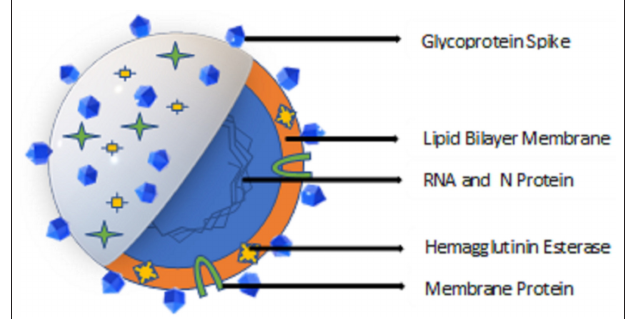
FIGURE 1 | Overview of Coronavirus